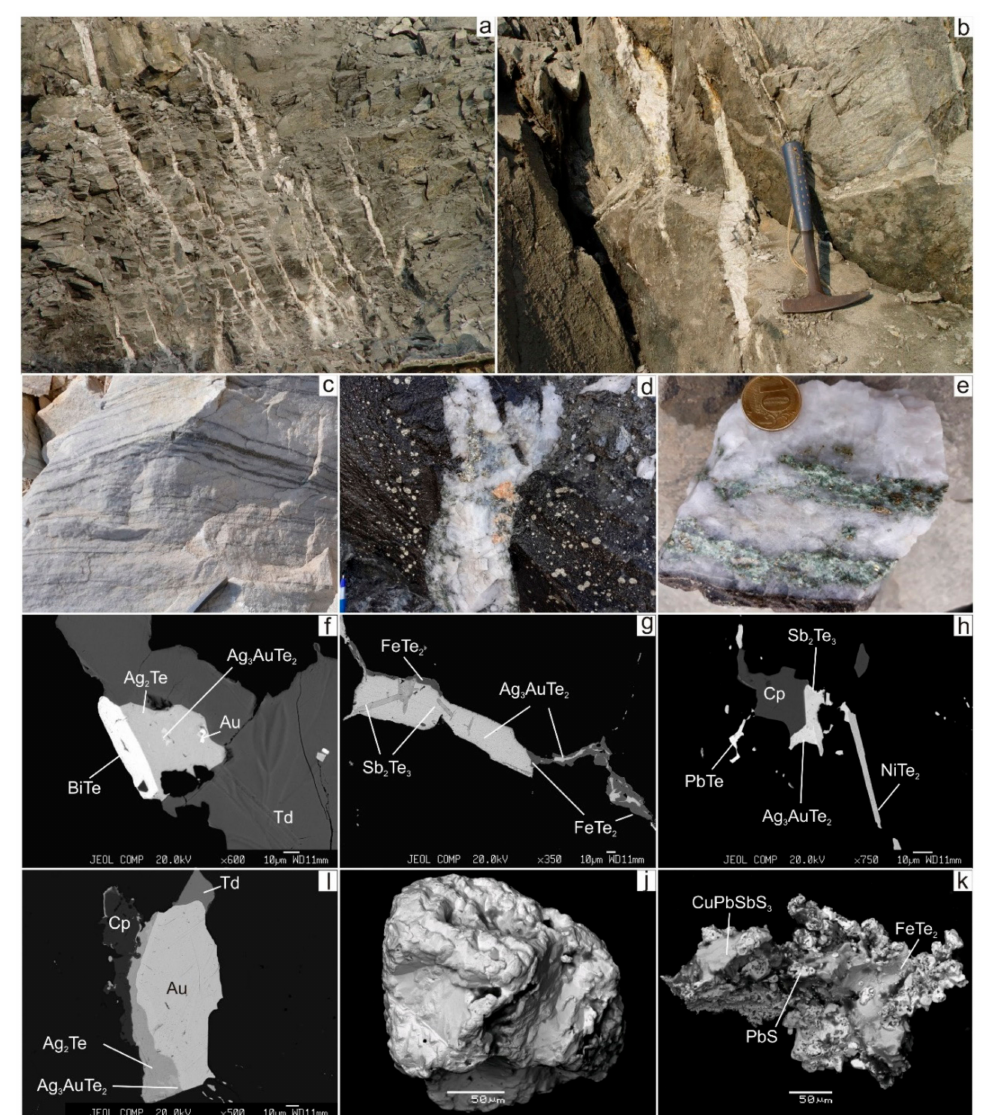
Figure 4. Mineralisation of the Svetlinsk gold deposit. ( a , b )—systems of gold-bearing sulphide-quartz veinlets and veins with thickness from the first centimetres to 0.2 m, superimposed on the stratiform bodies of disseminated sulphide mineralisation. ( c )—thin horizons of disseminated sulphide mineralisation in marble. ( d )—0.2 m thick gold-bearing sulphide-scheelite-quartz veins, intersected the disseminated pyrite mineralisation. ( e )—quartz vein with chlorite and sulphide mineralisation. ( f – i )—telluride mineralisation in quartz veins. ( j , k )—mineralisation in marble ( j —native gold, k —intergrowth bournonite with galena and frohbergite). Width of image is 3 m ( a ) and 50 cm ( c , d ). Td—tetrahedrite,